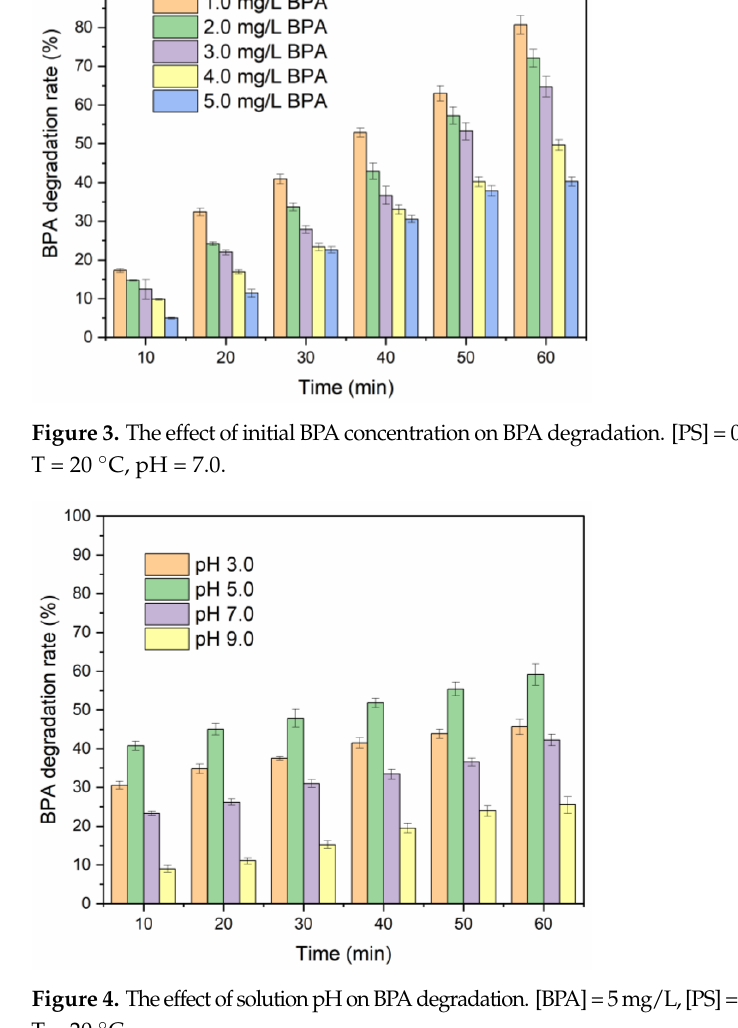
Figure 4. TheeffectofsolutionpHonBPAdegradation. [BPA]=5mg/L,[PS]=0.2mM,[magnetite] = 0.1 g/L, T = 20 ◦